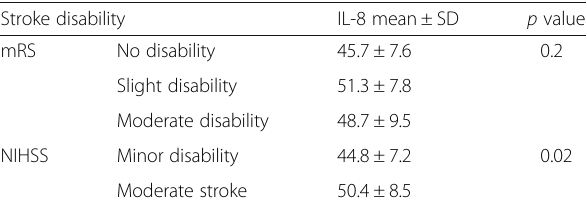
Table 1 Comparison between the different grades of disability as regards serum IL-8